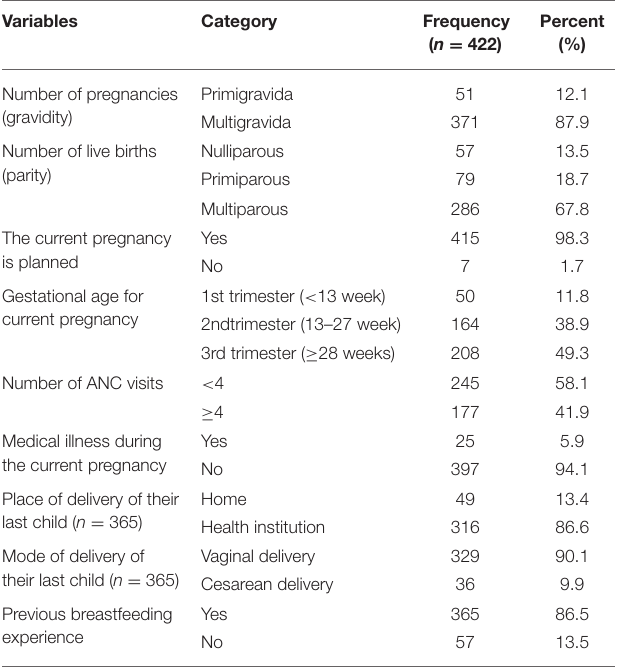
TABLE 2 | Obstetric and breast-feeding history of pregnant women attending the MCH clinic of DTCSH in Debre Tabor, Northwest Ethiopia, 2022.